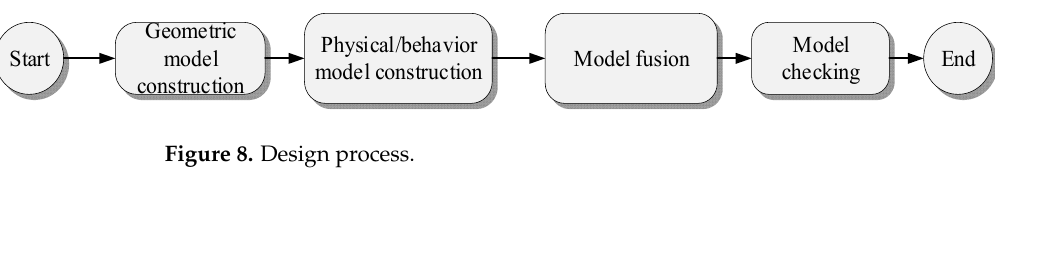
T 7 Figure 9. Modeling of the workflow integrated with model evaluation.